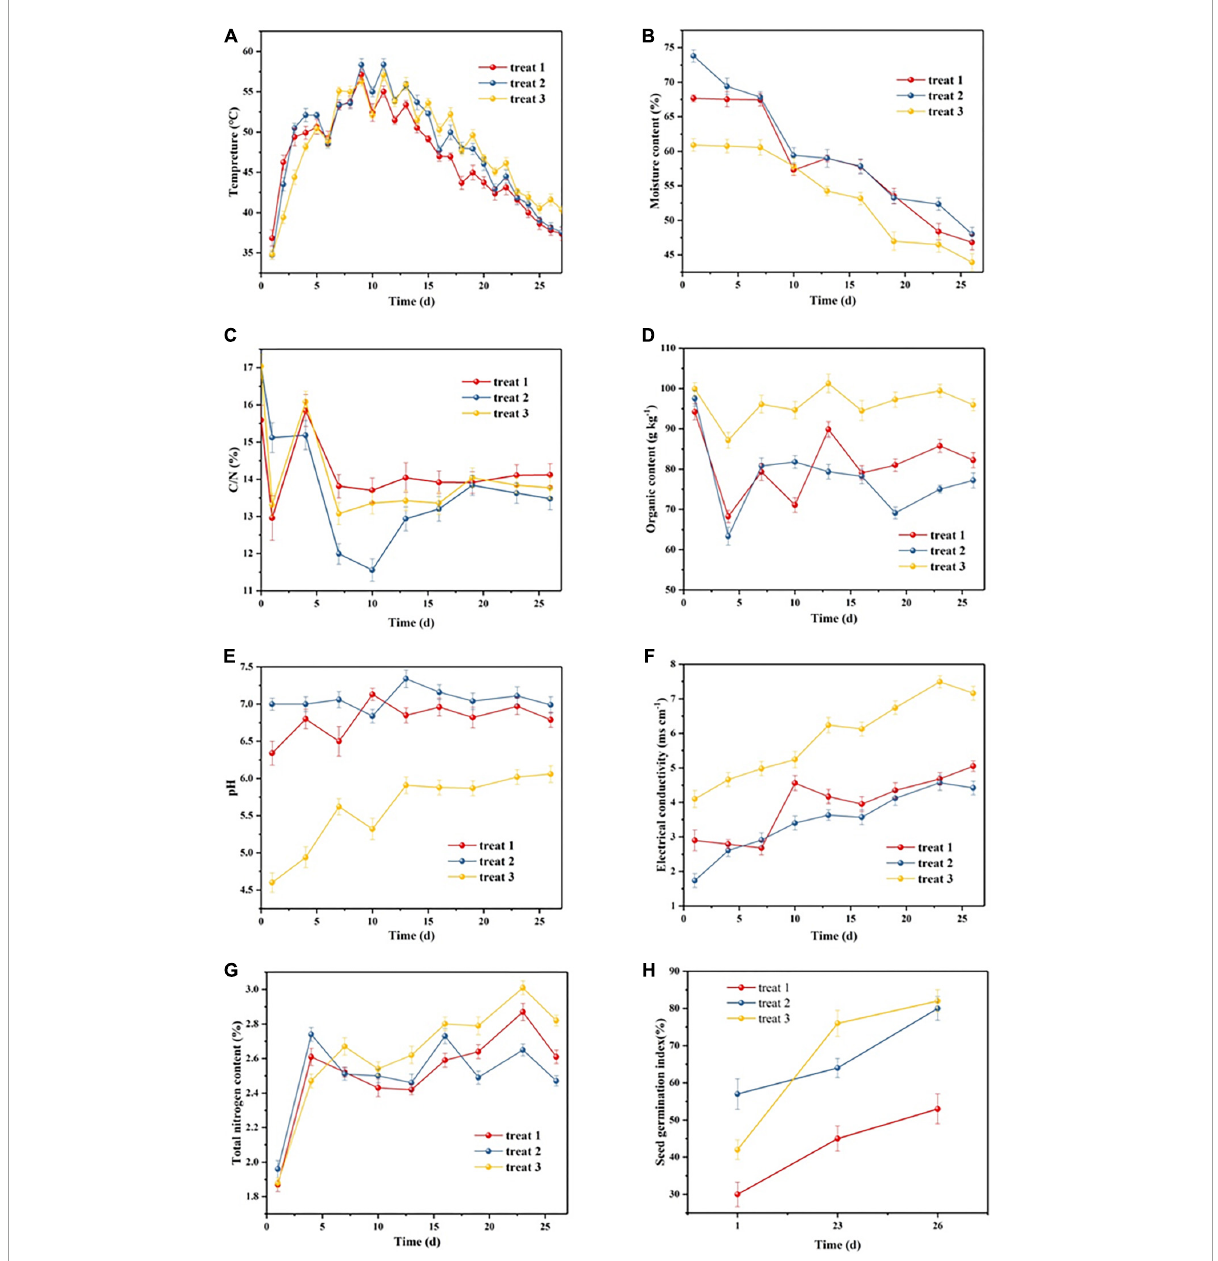
FIGURE1 Changes in physicochemical characteristics of different piles during the composting process. (A) Temperature, (B) moisture content, (C) C/N, (D) organic matter content, (E) pH, (F) electrical conductivity, (G) total nitrogen content, and (H) seed germination index. Error bars represented standard deviation ( n =